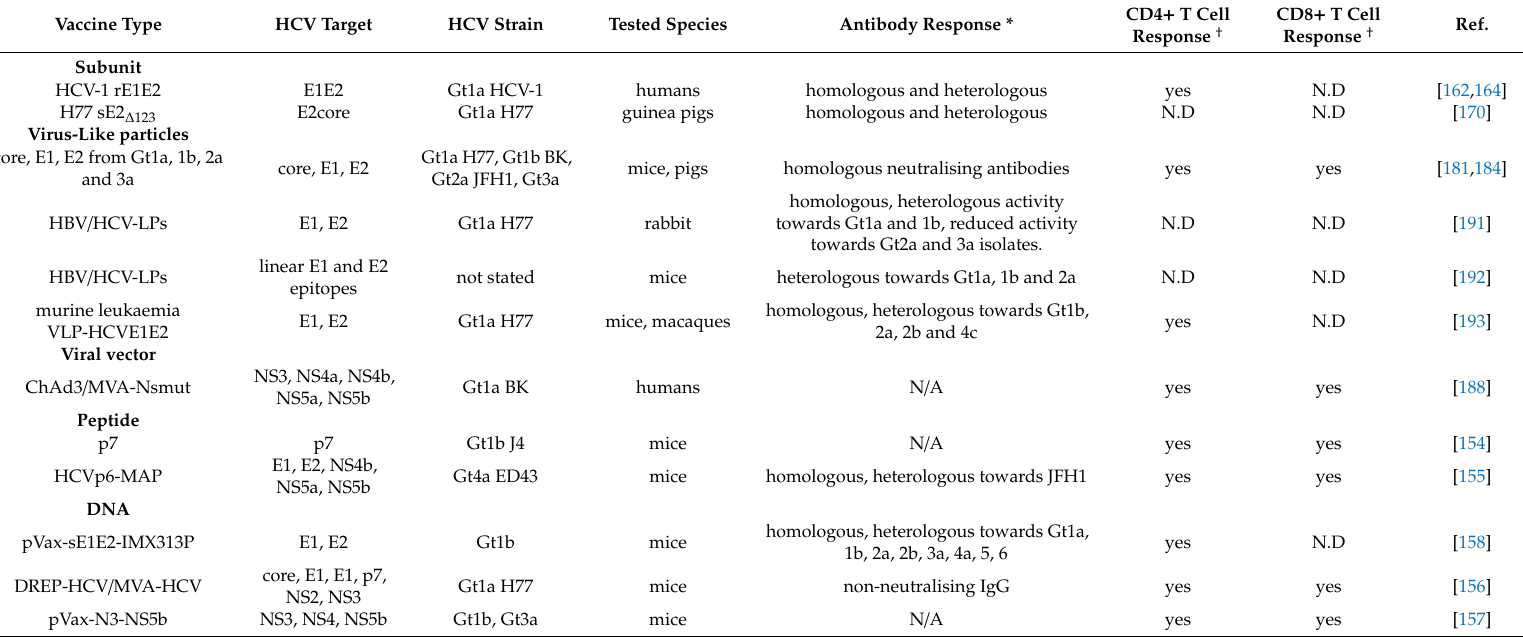
Table 1. Summary of recent hepatitis C virus vaccine candidates. Subunit, virus-like particle (VLP), viral vector, peptide and DNA vaccine approaches are listed with the vaccine target, genotype (Gt) and isolate from which the candidate was derived, tested species and the humoral and cellular immune responses were